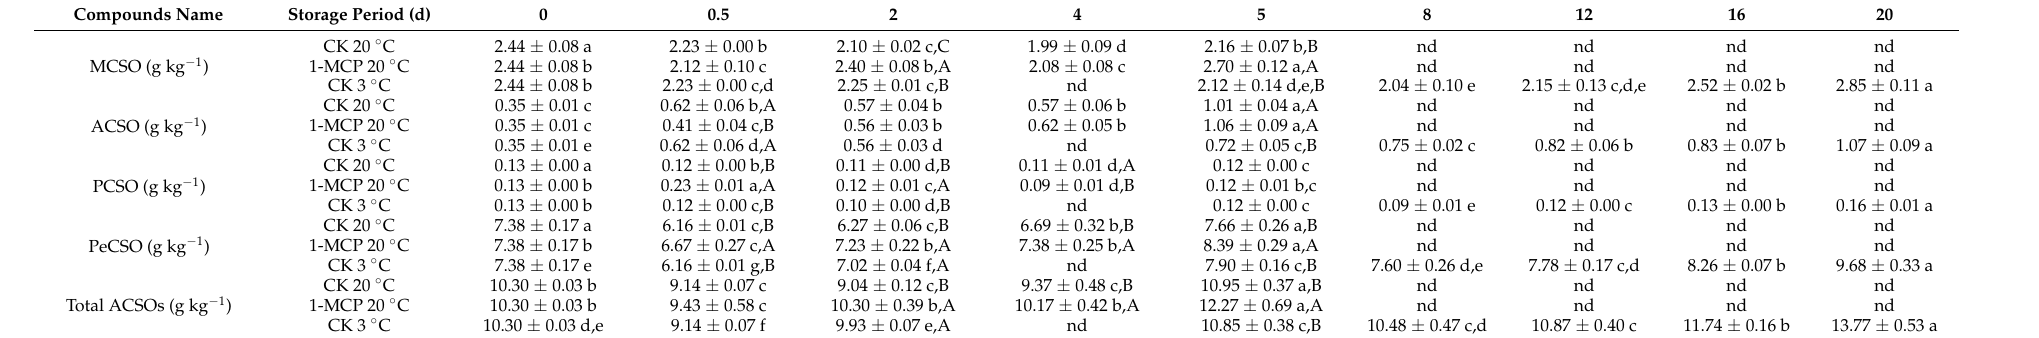
Table 2. S-alk(en)ylcysteine sulfoxides (ACSOs) content in